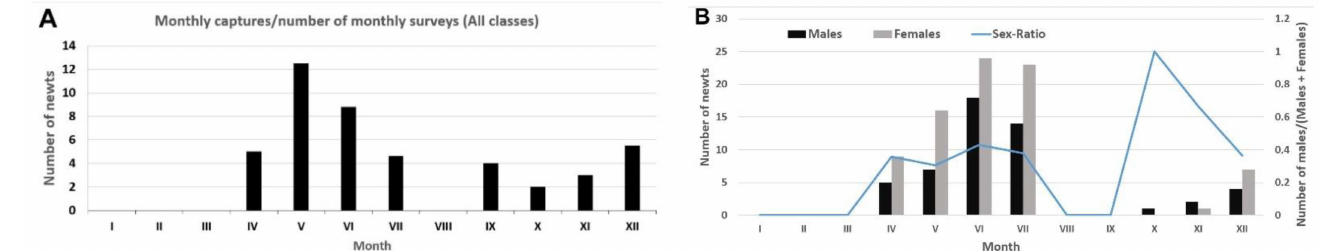
Figure 9. ( A ): Number of individuals from 2018 to 2020 in the A2 stream, captured by surveys in relation to number of surveys for each month. ( B ): Monthly Sex-Ratio in the A2 stream and absolute number of males and females captured each month.